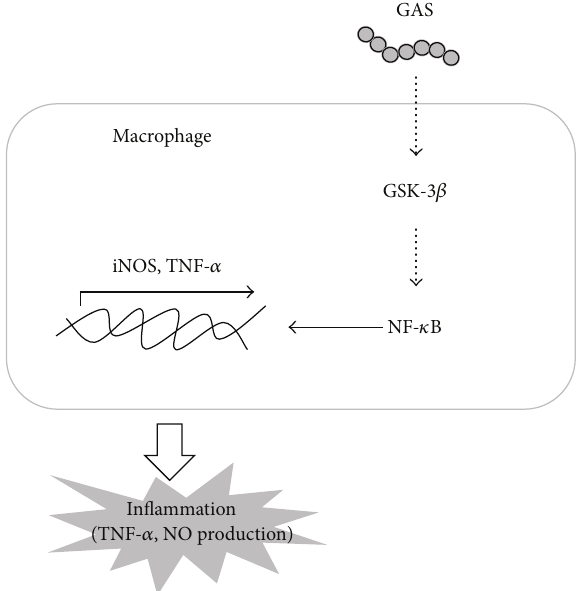
Figure 5: The signaling pathway of group A streptococcus- induced GSK-3 𝛽 activation, which leads to increased NF- 𝜅 B nuclear translocation and upregulation of TNF- 𝛼 and NO production in